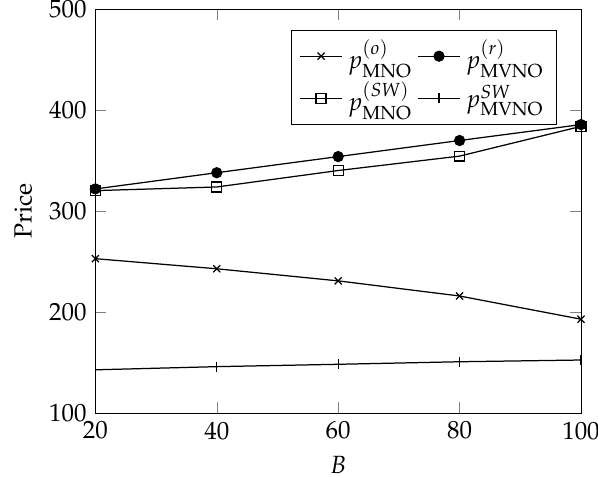
Figure 8. Impact of bandwidth on prices with three